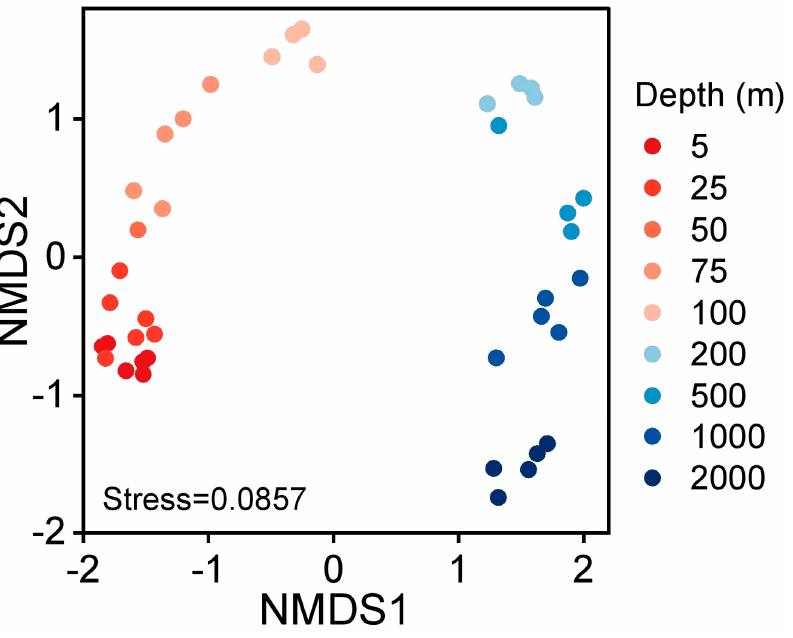
Figure 6. Nonmetric multidimensional scaling (NMDS) plot illustrating the dissimilarities among the bacterial communities of different depths.